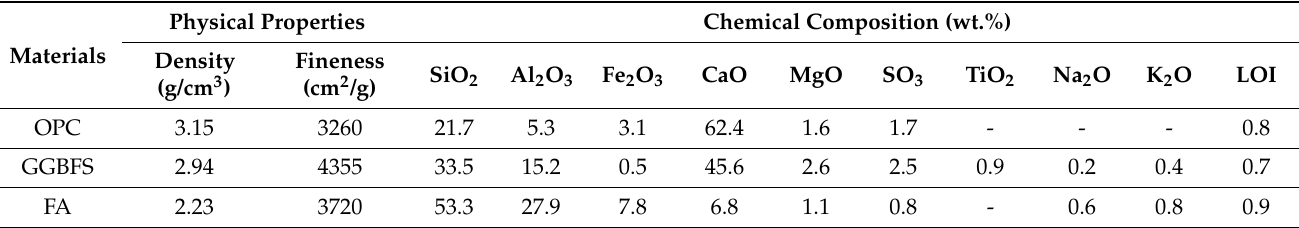
Table 1. Properties of cementitious materials for coating materials.